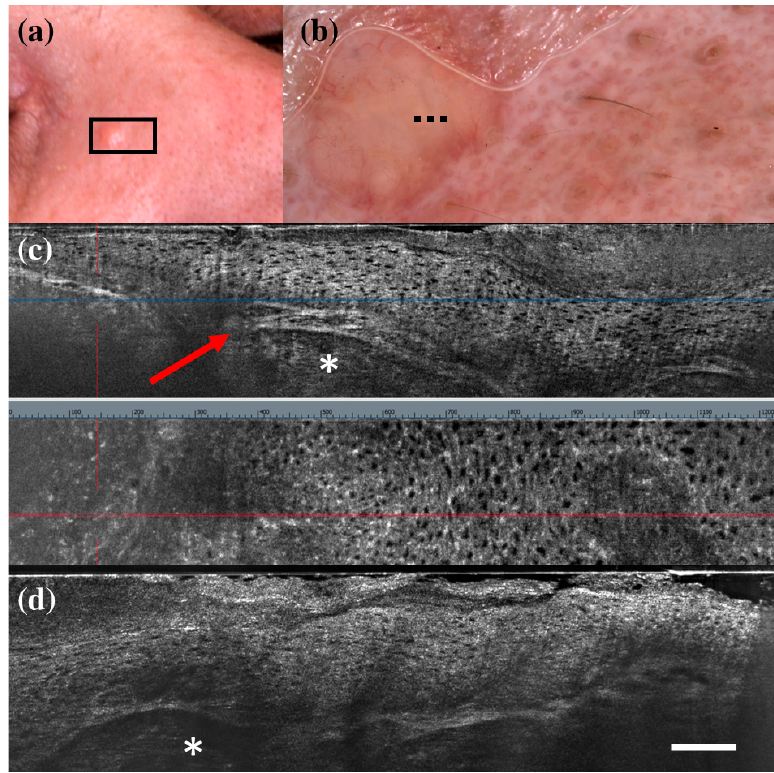
Figure 3. Sebaceoma diagnosed as basal cell carcinoma at dermoscopy and line-field confocal optical coherence tomography (LC-OCT). Clinical ( a ), dermoscopic ( b ), and LC-OCT images ( c , d ). Dermoscopy shows a pinkish-yellowish background and linear vessels. LC-OCT reveals a large lobular structure (asterisk) with “feuilletage” and clefting, surrounded by hyperreflective stroma and connected to a hair follicle (red arrow). Dashed line ( b ) indicates the approximate area of the LC-OCT imaging. White scale bar in LC-OCT images: 100 μ m.